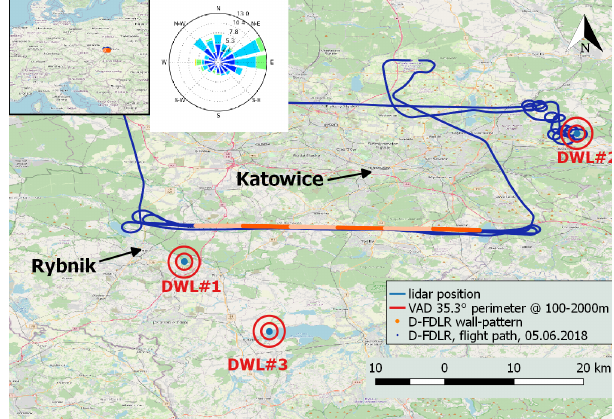
Figure 2. Sketch of the measurement site in Upper Silesia. Red cir- cles show the extent of the VAD scan at 35.3 ◦ for 100 and 2000m at the respective lidar location. The orange line marks the flight path of D-FDLR on 5 June 2017. The different shades of orange are used to indicate a subdivision of the flight leg in shorter sub-legs. Map